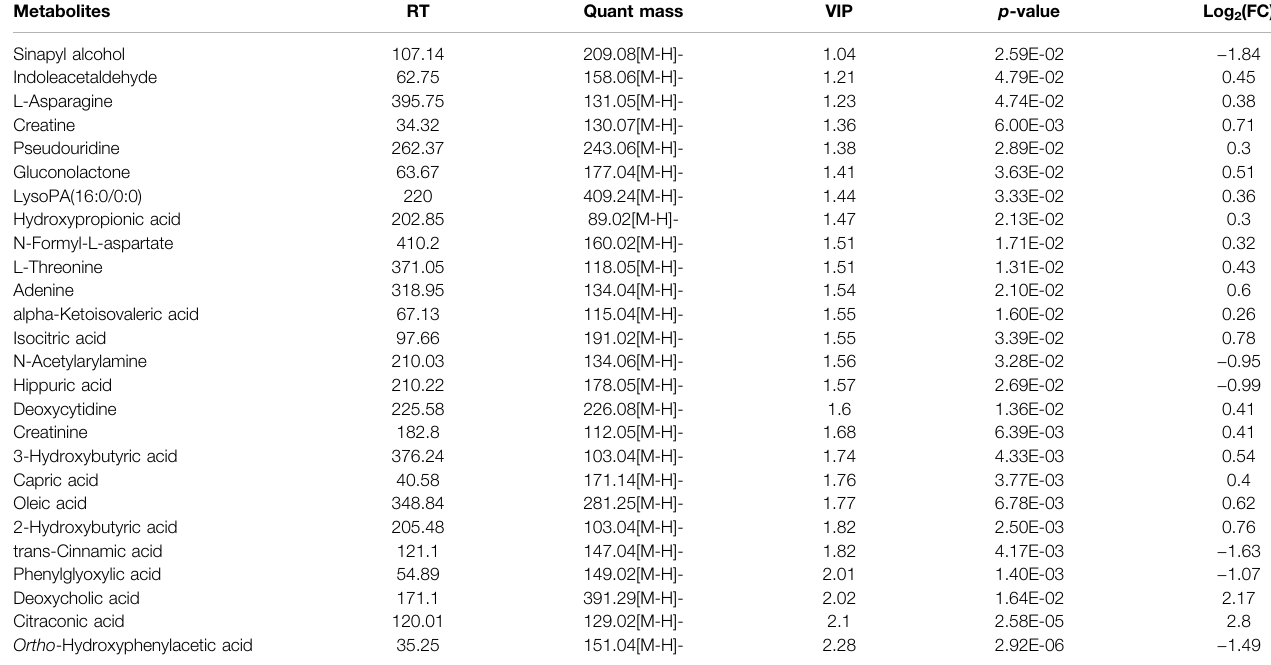
TABLE 2 | Effect of NaoMaiTong (NMT) on 26 gut-derived metabolites of MCAO/R male rats were obtained from the negative ion scan modes. Metabolites